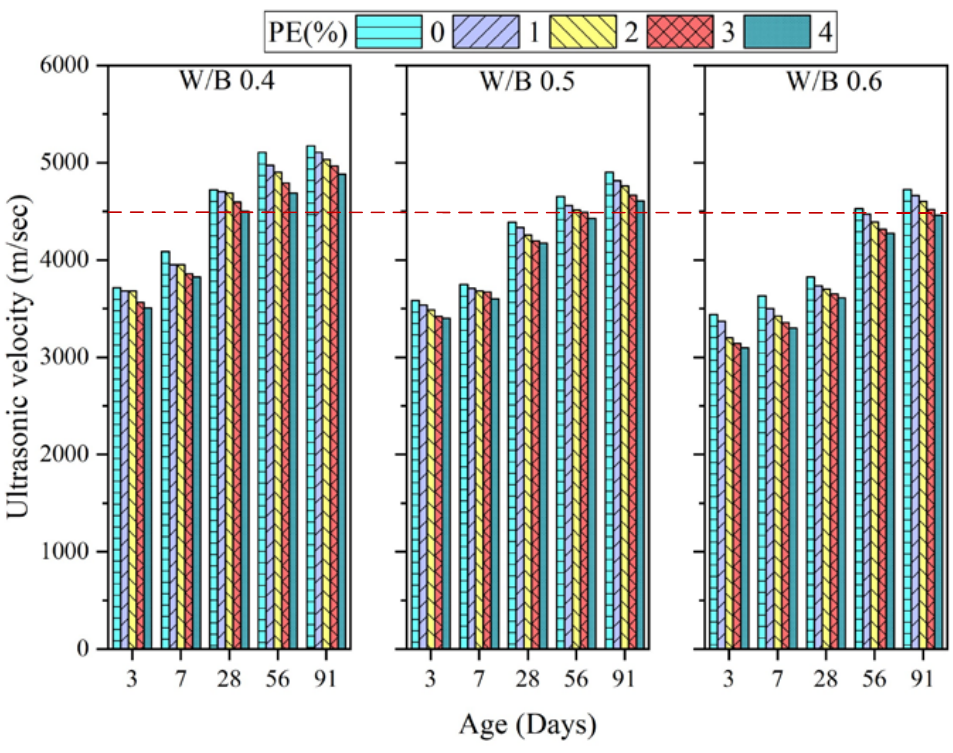
Figure 8. Ultrasonic velocity of cement mortar with different W/B ratios and waste PE.